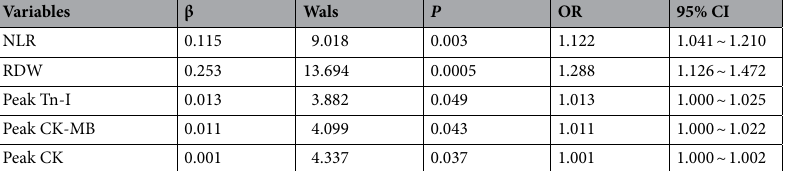
Variables β Wals P